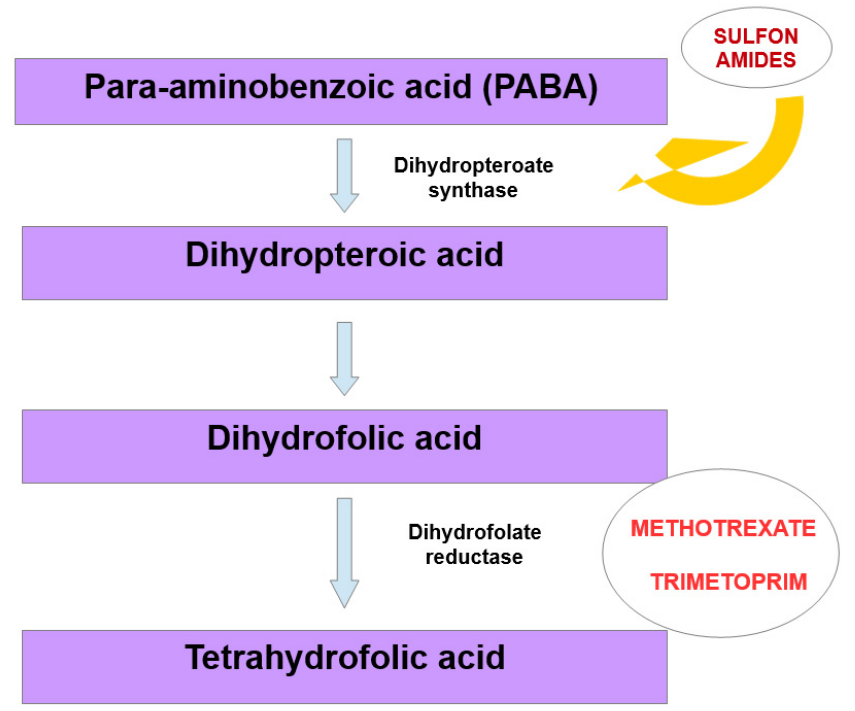
Figure 3. Mechanism that may lead to megaloblastic anemia, due to structural similarity between bacterial and human dihydrofolate reductase.